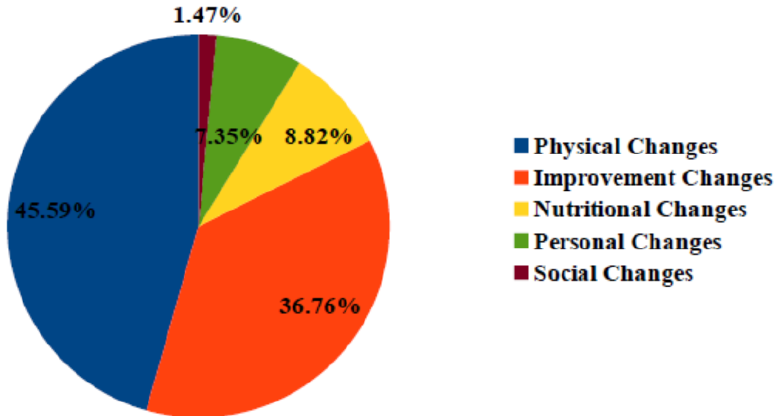
Figure 11. Possible cause rates of detected changes in individual